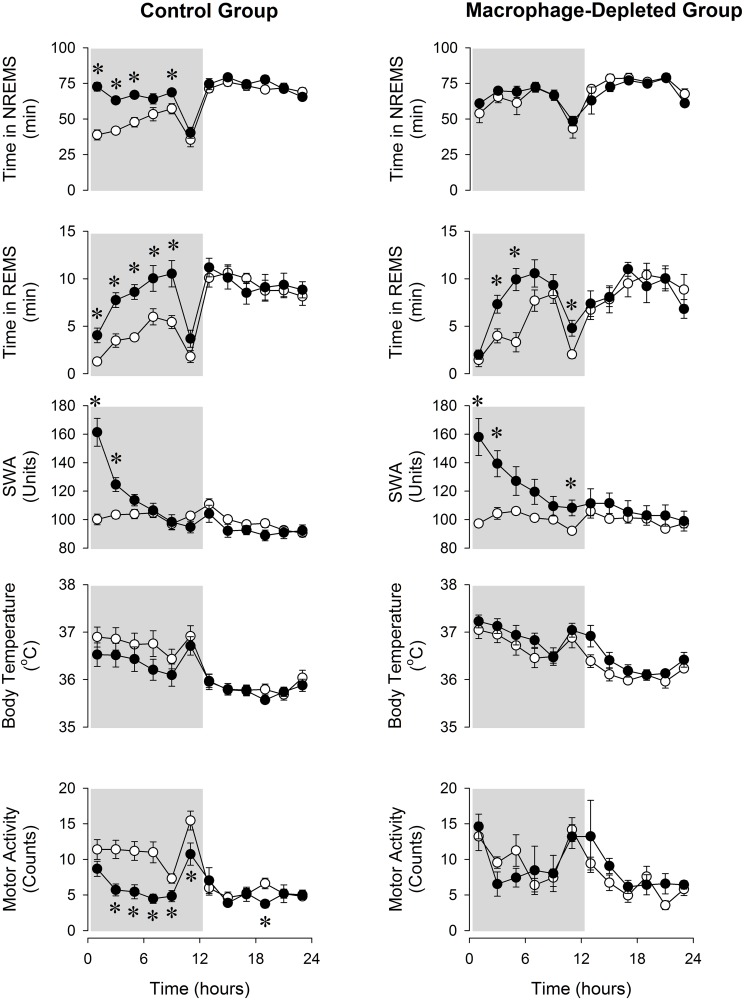
NREMS, REMS, EEG SWA, and body temperature in control and macrophage-depleted mice on the baseline day (open symbols) and after 6 h sleep deprivation (solid symbols).See legends to Fig 2 for details.